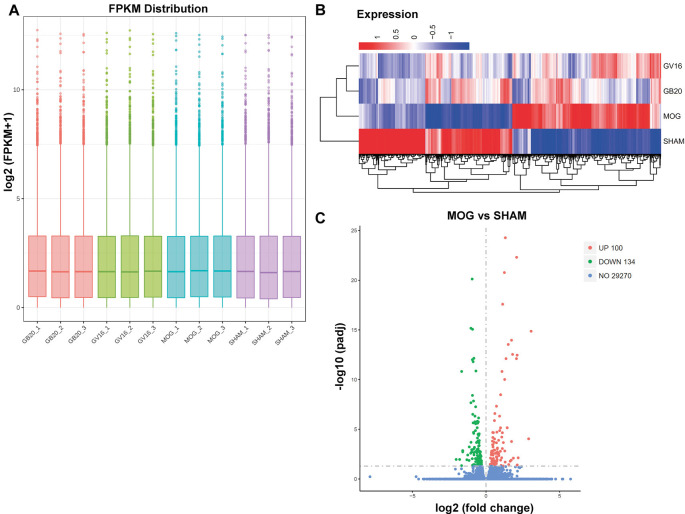
Quantitative analysis of retinal gene expression. (A) Boxplot shows the overall range and distribution of fragments per kilo base per million (FPKM) value of gene expression. (B) Cluster analysis of differentially expressed genes among groups. The colors of the heat map indicate the relative gene expression. Red color indicates the higher gene expression, while blue color indicates the lower gene expression. (C) The volcano map shows the numbers of differentially expressed genes (DEGs) of retina after myelin oligodendrocyte glycoprotein (MOG) immunization, compared with SHAM control. padj: adjusted p-value.